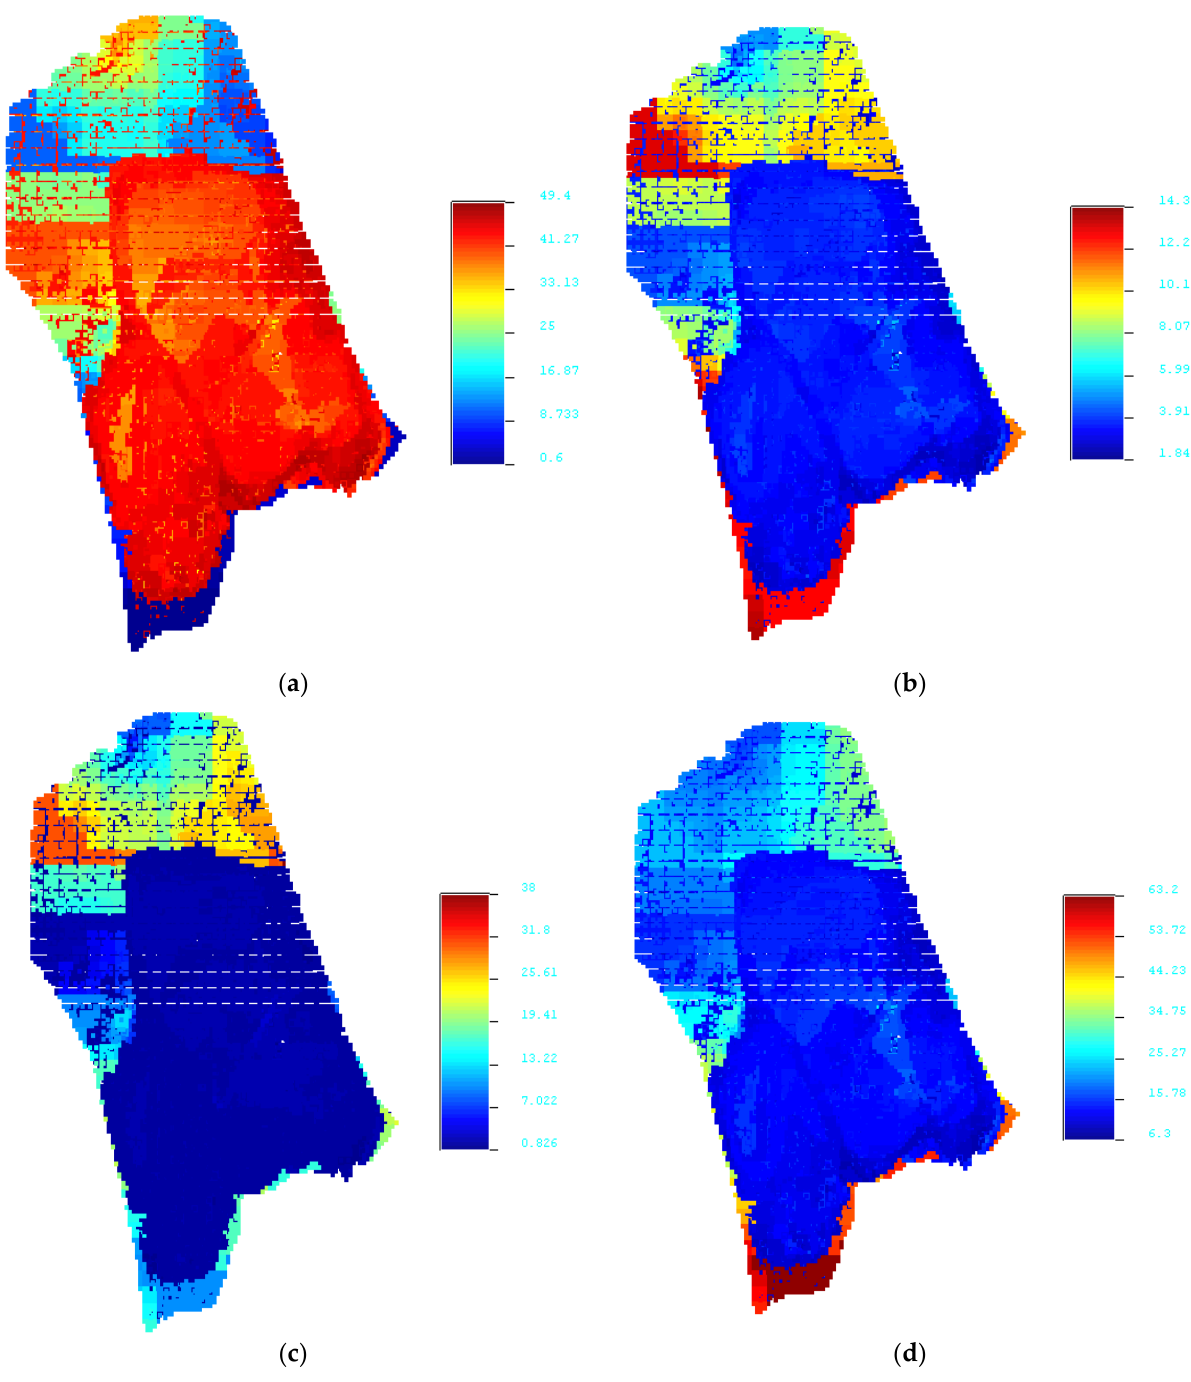
Figure 2. Resource models of CaO, Al 2 O 3 , SiO 2 , and Fe 2 O 3 for the southern block. ( a ) CaO; ( b ) Al 2 O 3 ; ( c ) Fe 2 O 3 ; ( d ) SiO 2 .